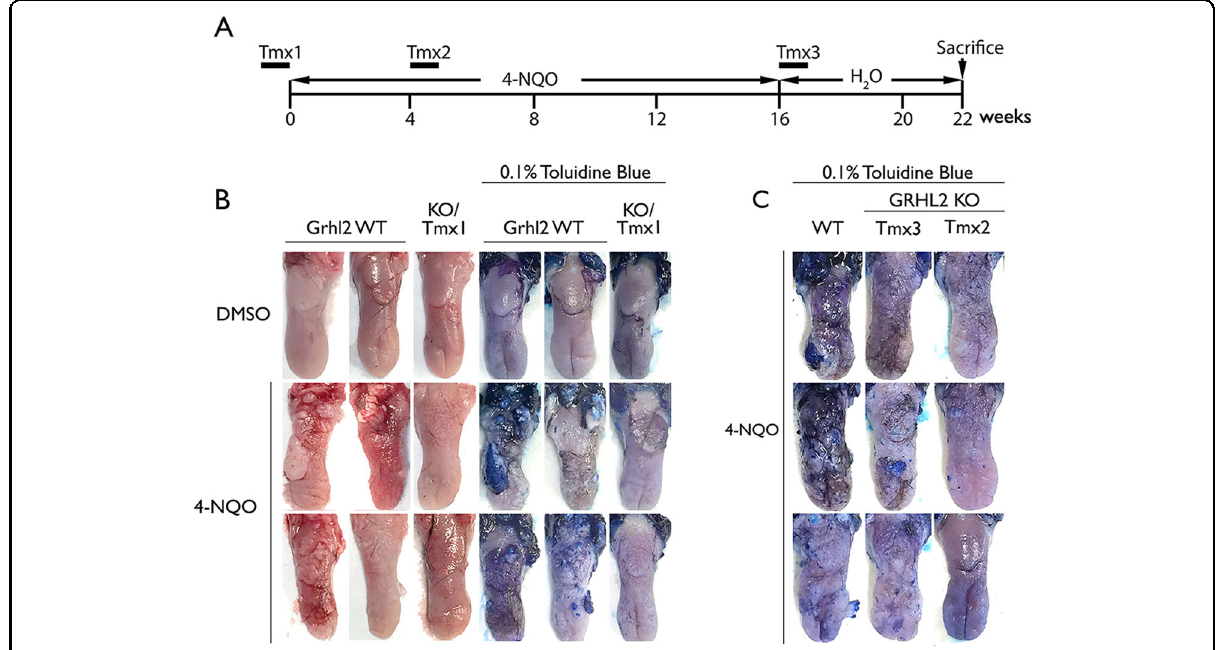
Fig. 3 Grhl2 KO prevents chemical carcinogen-induced tongue carcinogenesis. a Grhl2 KO was induced by tamoxifen (Tmx, 75 mg/kg) administration for 7 consecutive days, immediately prior to 4-NQO (30 μ g/ml) exposure (Tmx1, n = 6), after 4-week exposure to 4-NQO (Tmx2, n = 3), or after 16 weeks of 4-NQO exposure (Tmx3, n = 3). These WT mice ( n = 7) and KO mice (total n = 12) were all exposed to 4-NQO for 4 months, and then maintained for additional 6 weeks in drug-free drinking water before they were killed. For comparison, we also included Grhl2 WT ( n = 5) and KO ( n = 5) mice exposed to DMSO, which did not elicit tumor development in any mice. b Grhl2 WT and KO (Tmx1) tongues were harvested and stained with 0.1% toluidine blue after exposure to 4-NQO for 16 weeks, and representative specimens are shown. c Grhl2 WT and KO (Tmx2 and Tmx3) tongues were stained with 0.1% toluidine blue after 4-NQO exposure. Representative staining results were shown for tongues of mice in various groups